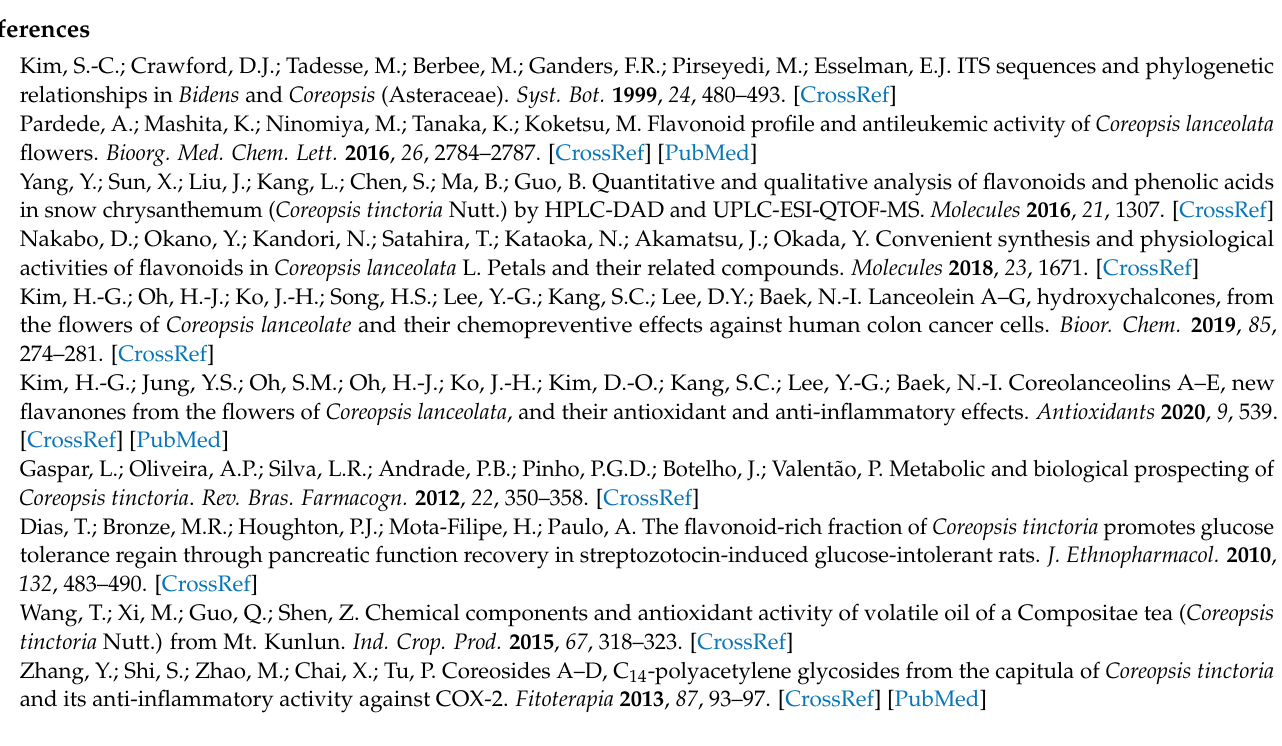
(peak 19), Figure S21: ESI-QTof-MS spectrum of quercetin-7- O -glucoside (peak 20), Figure S22: ESI-QTof-MS spectrum of maritimein (peak 21), Figure S23: ESI-QTof-MS spectrum of luteolin-7- O-glucoside (peak 22), Figure S24: ESI-QTof-MS spectrum of marein (peak 23), Figure S25: ESI- QTof-MS spectrum of taxifolin 3 (cid:48) ,7-dimethyl ether 3- O -glucoside (peak 24), Figure S26: ESI-QTof-MS spectrum of 3,3 (cid:48) ,4 (cid:48) -trihydroxy-7-methoxyflavone 3- O -glucoside (peak 25), Figure S27: ESI-QTof-MS spectrum of qurcetagetin-7- O -(6 (cid:48)(cid:48) -caffeoylglucoside) (peak 26), Figure S28: ESI-QTof-MS spectrum of 3,5-dicaffeoylquinic acid (peak 27), Figure S29: ESI-QTof-MS spectrum of sulfuretin (peak 28), Figure S30: ESI-QTof-MS spectrum of luteolin-6- O -rhamnoside (peak 29), Figure S31: ESI-QTof-MS spectrum of coreopsin (peak 30), Figure S32: ESI-QTof-MS spectrum of 4,5-dicaffeoylquinic acid (peak 31), Figure S33: ESI-QTof-MS spectrum of okanin (peak 32), Figure S34: ESI-QTof-MS spectrum of eriodictyol chalcone- O -diglucoside (peak 33), Figure S35: ESI-QTof-MS spectrum of eriodictyol chalcone (peak 34), Figure S36: ESI-QTof-MS spectrum of kaempferide (peak 35), Figure S37: ESI-QTof- MS spectrum of luteolin (peak 36), Figure S38: ESI-QTof-MS spectrum of 4-methoxylanceoletin-4 (cid:48) - O - glucoside (peak 37), Figure S39: ESI-QTof-MS spectrum of butein (peak 38), Figure S40: ESI-QTof-MS spectrum of apigenin (peak 39), Figure S41: ESI-QTof-MS spectrum of unknown (peak 40), Figure S42: ESI-QTof-MS spectrum of lobetyolinin (peak 41), Figure S43: Validation plot of the OPLS-DA obtained from 200 permutation